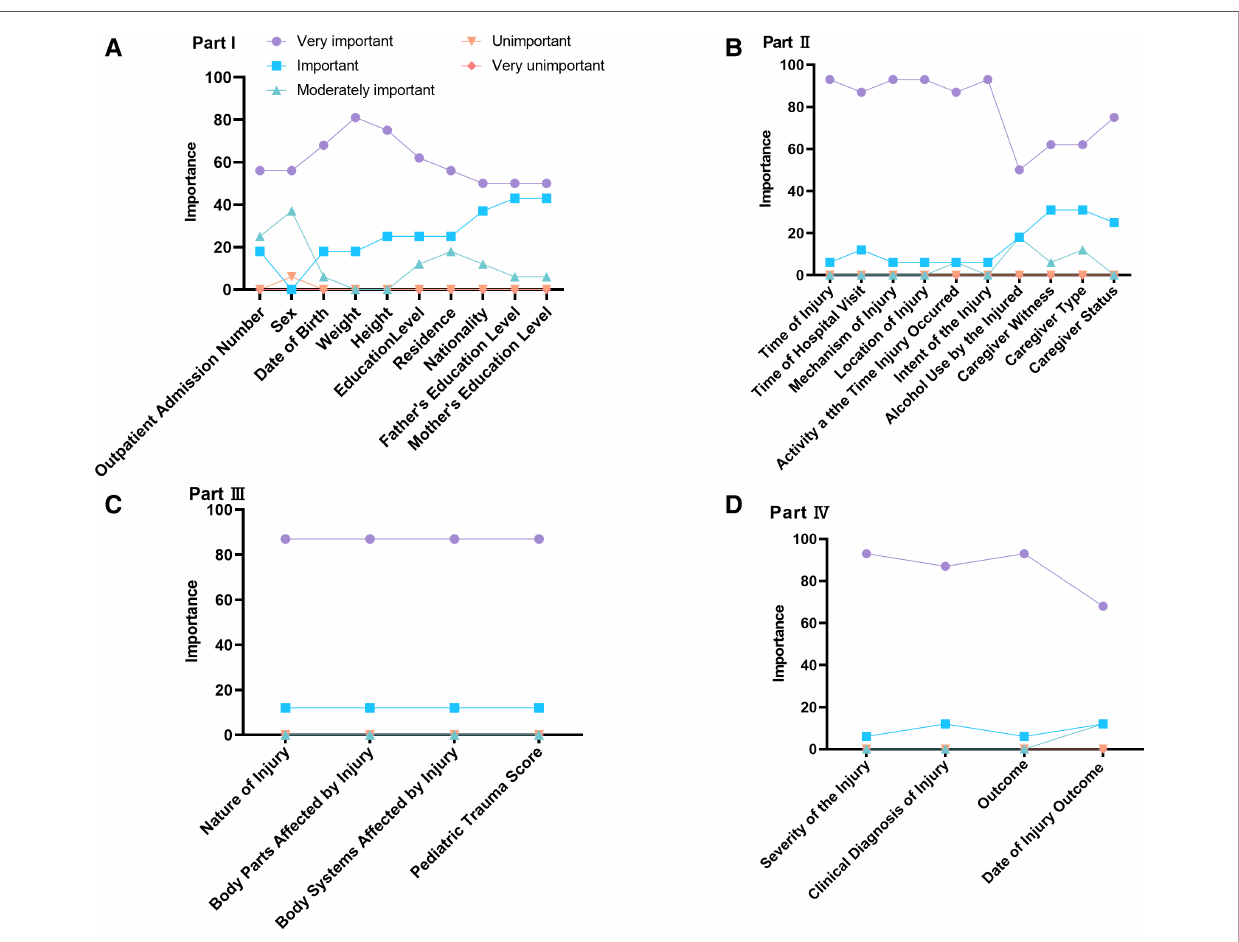
FIGURE 2 Importance of evaluating items in the draft child injury surveillance CDS based on expert opinion. ( A ) Part I: General patient information; ( B ) Part II: Basic injury information; ( C ) Part III: Clinical injury information; ( D ) Part IV: Injury outcome